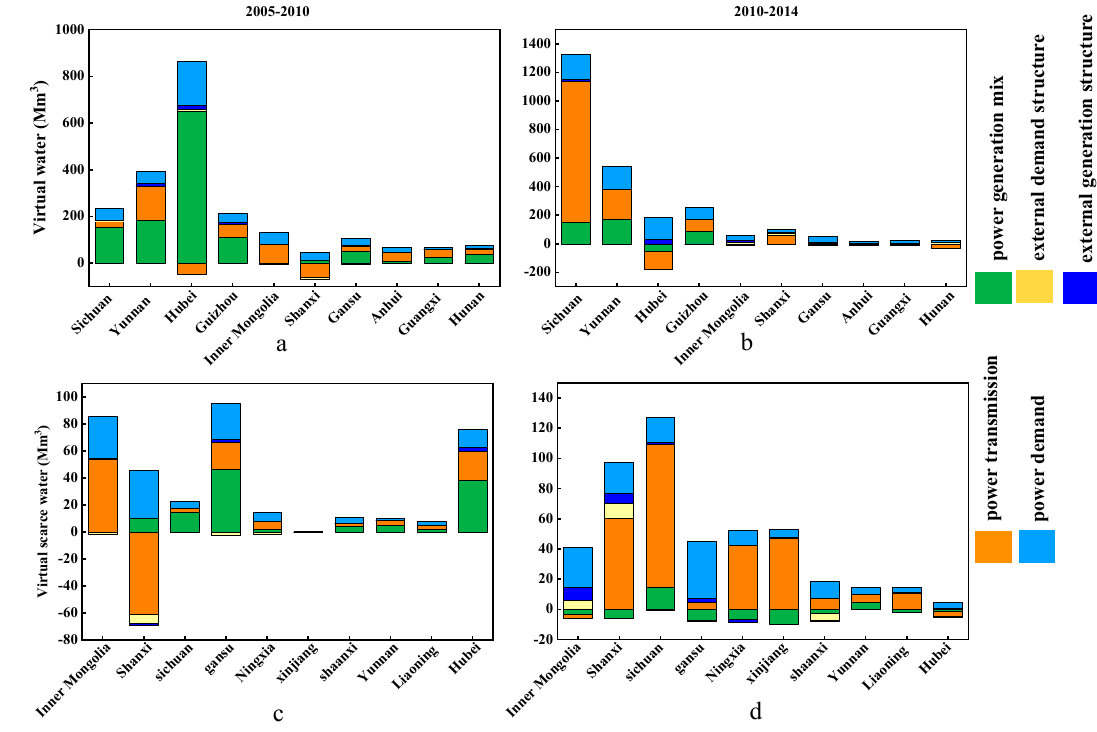
Figure 9. The evolution of virtual water transmission ( a , b ), and virtual scarce water transmission ( c , d ) of top ten provinces in two periods.